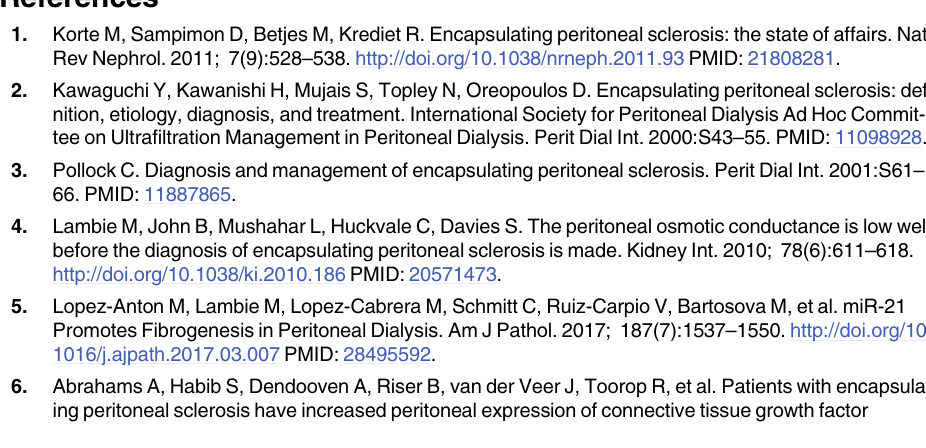
S1 Table. Risk assessment of the included studies using ROBINS-I tool. S2 Table. Publication bias associated with potential risk factors for